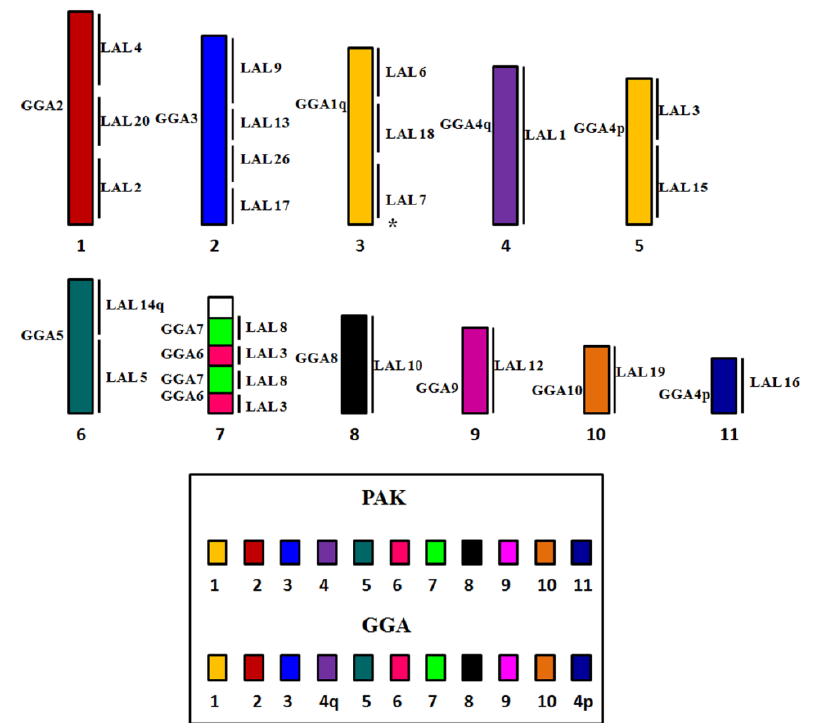
Figure 7. Schematic representation of the PAK of the Tribe Arini, showing fission in PAK 1 and association of PAK6/7, according to FISH results with probes of L . albicollis and G . gallus in species of Neotropical Psittacidae. Segments not hybridized with LAL probes are indicated with an asterisk.